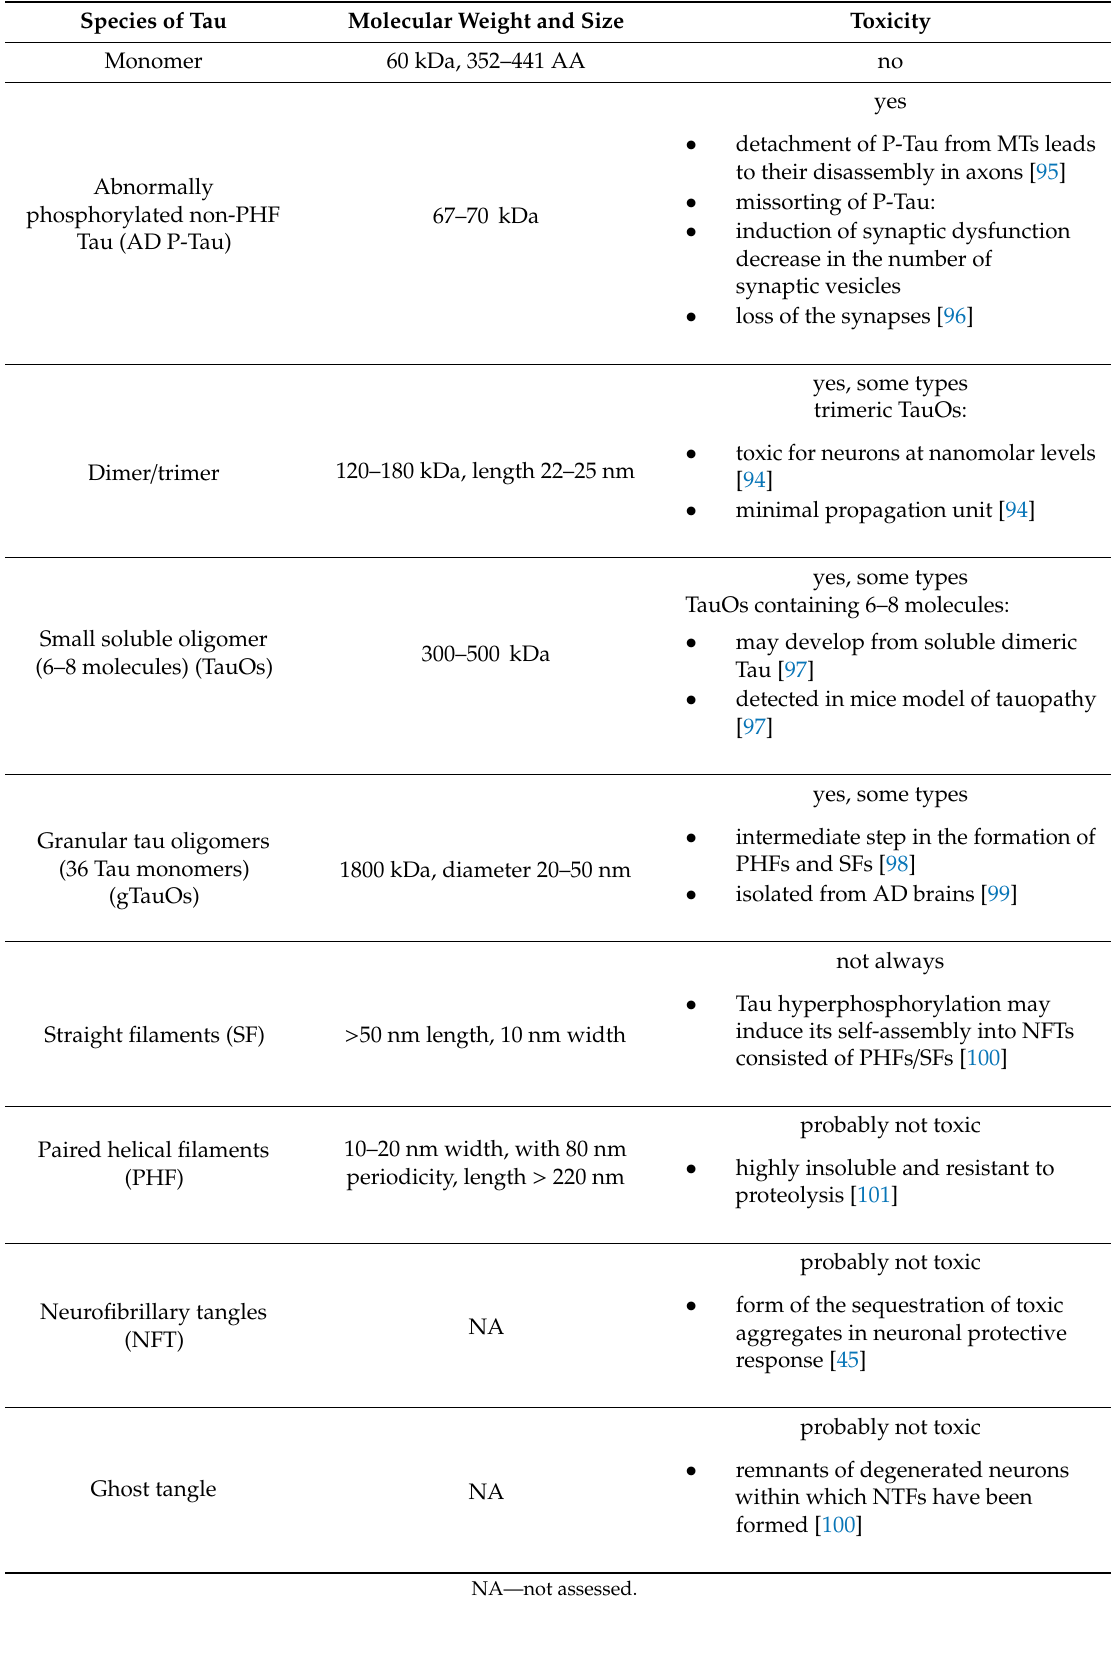
Table 1. Major forms of Tau